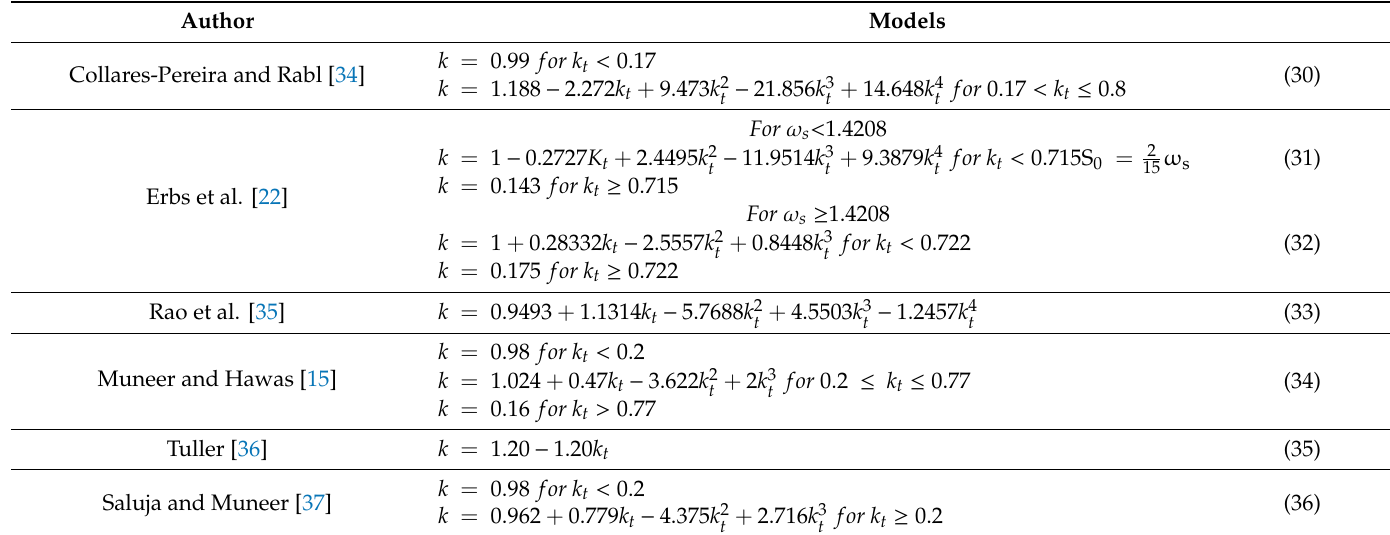
Table 2. Daily Average Di ff use Irradiation